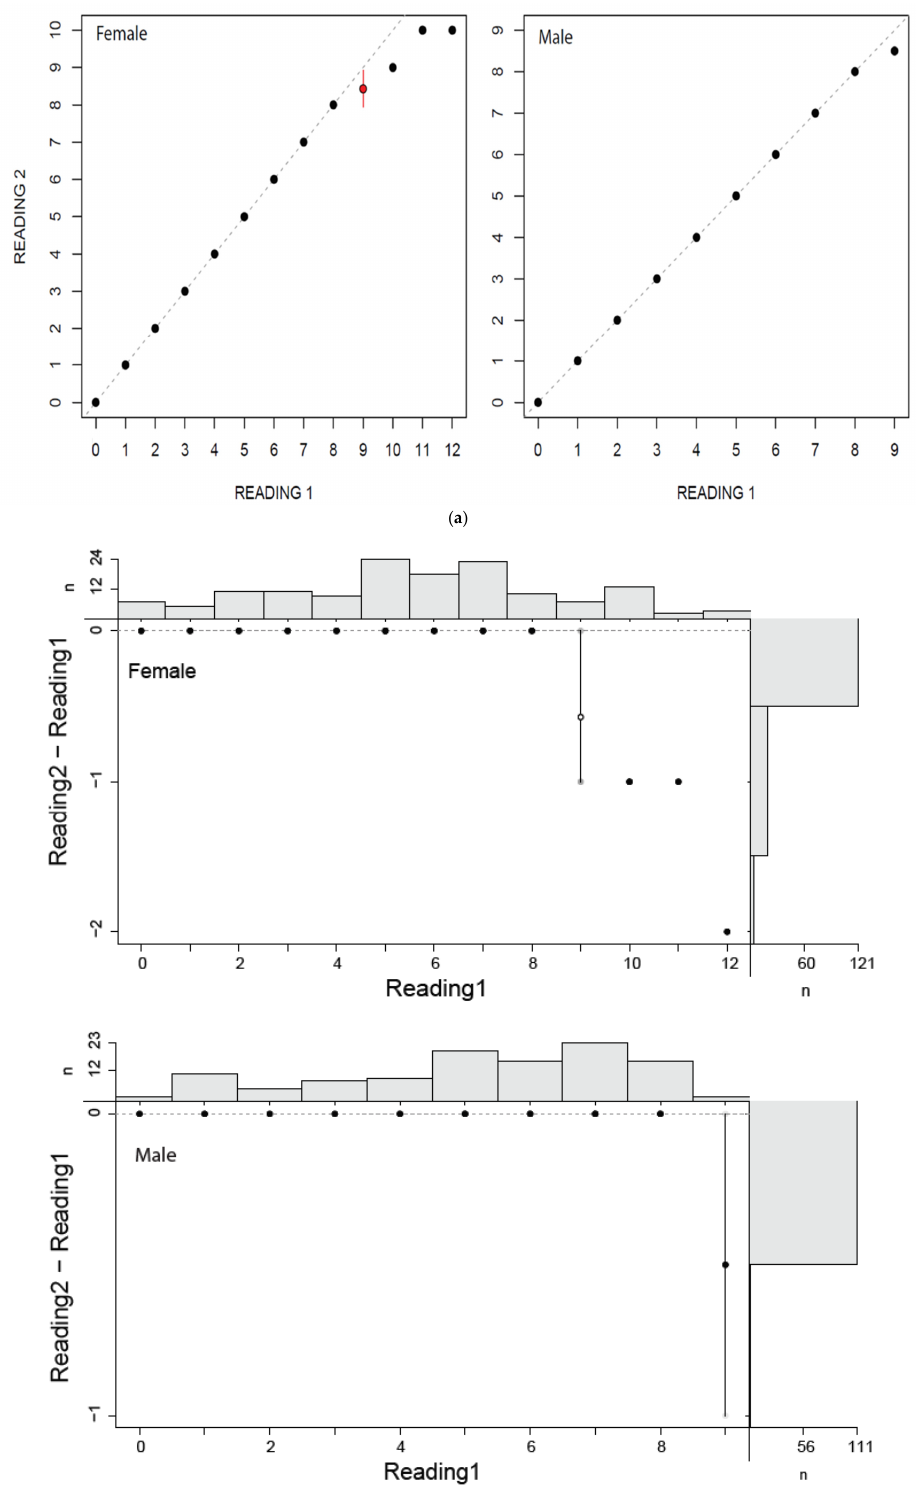
Figure 4. ( a ) Age bias graphs for Dipturus oxyrinchus inhabiting the Northeastern Mediterranean Sea. ( b ) Age bias plots for two readers for aging Dipturus oxyrinchus inhabiting the Northeastern Mediterranean Sea. Plots illustrate reference reader’s age estimates on the x -axis; the mean difference (circles) and distribution of the differences between corresponding ages (vertical lines) are represented on the y -axis.